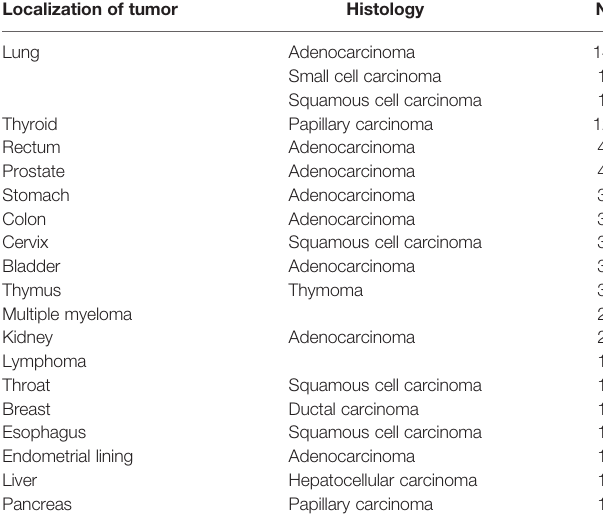
TABLE 4 | Types of cancer among 62 patients with